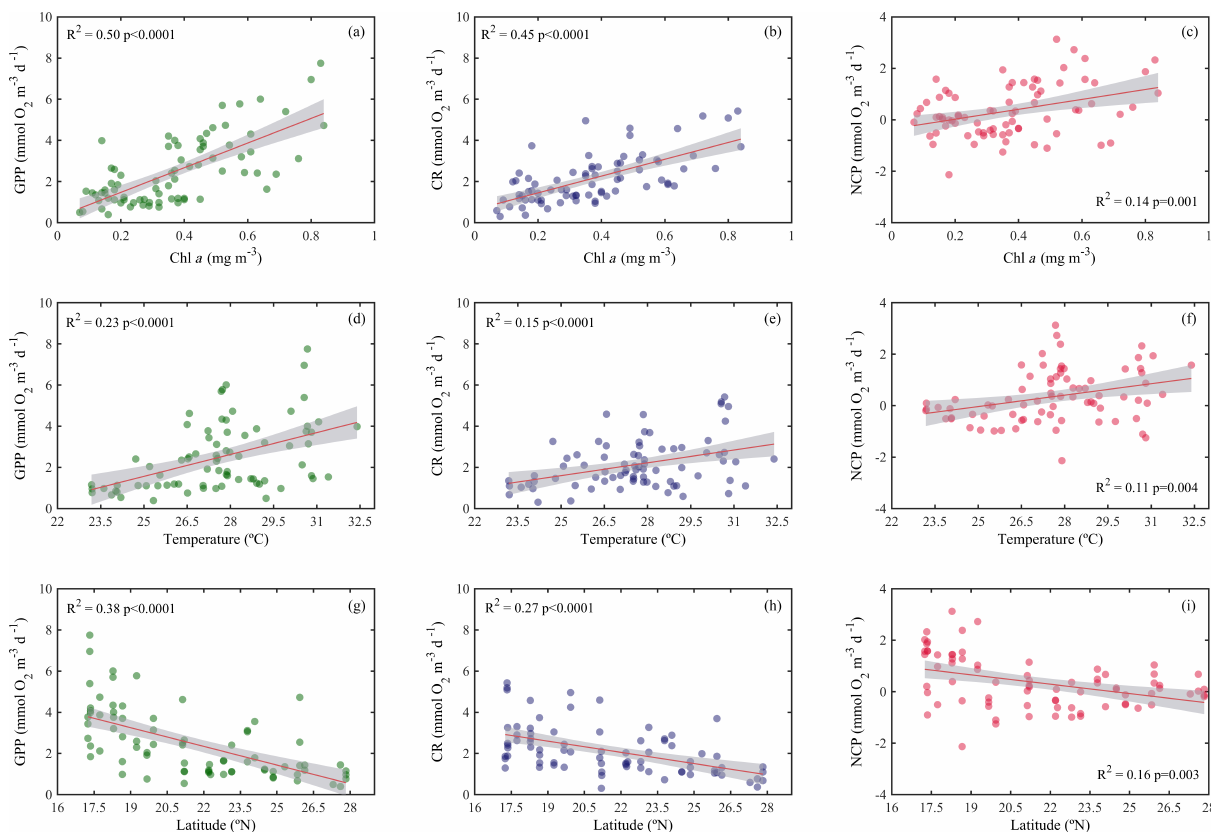
Figure 4. Ordinary least squares linear regression between gross primary production (GPP), planktonic community respiration (CR), and net community production rates (NCP) with (a, b, c) chlorophyll a concentration (Chl a ), (d, e, f) temperature, and (g, h, i) latitude. The solid red line is the linear least square fit, while the shaded grey area represents the 95% confidence intervals. The coefficient of determination and the statistical significance are indicated for each regression. Table 1. Pearson correlation matrix between volumetric gross primary production (GPP), planktonic community respiration (CR), and net community production (NCP) with environmental variables (temperature; latitude; nitrite + nitrate, NO x ; chlorophyll a concentration, Chl a ). Bold numbers indicate significant relationships and the significance levels are indicated by ∗ p< 0 . 05, ∗∗ p< 0 . 01, and ∗∗∗ p< 0 . 001. Temperature Latitude NO x Chl a GPP CR NCP GPP 0.5 ∗∗∗ − 0.6 ∗∗∗ 0.0 0.7 ∗∗∗ 0.8 ∗∗∗ 0.7 ∗∗∗ CR 0.4 ∗∗∗ − 0.5 ∗∗∗ 0.2 0.7 ∗∗∗ 0.8 ∗∗∗ 0.1 NCP 0.3 ∗∗ − 0.4 ∗∗∗ − 0.1 0.4 ∗∗∗ 0.7 ∗∗∗ 0.1 Chl a 0.1 − 0.4 ∗∗∗ 0.3 ∗ 0.7 ∗∗∗ 0.7 ∗∗∗ 0.4